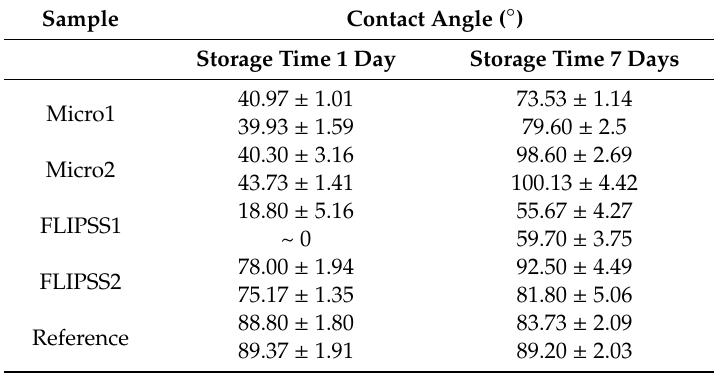
Table 3. Contact angle results after 1 and 7 days after laser treatment. The values are listed separately for each